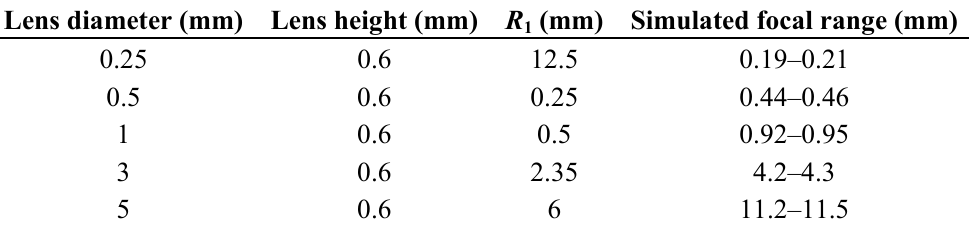
Table1. Theoretical results for various lens diameters and their respective focal lengths. R is defined in Figure 1